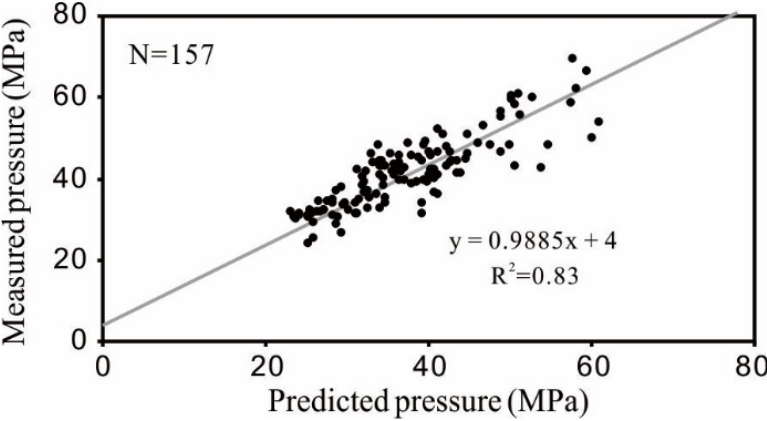
Figure 4. Relationship between DST pressures and predicted pressures in the upper interval of Es4 member of Dongying